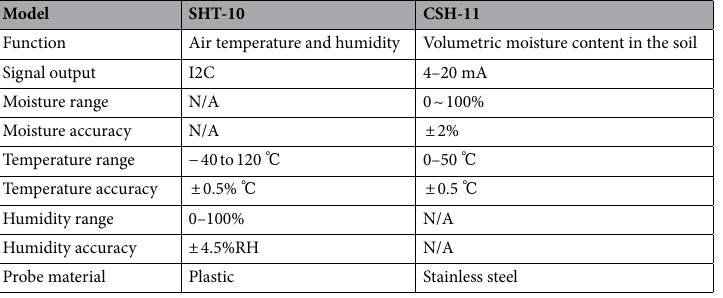
Table 4. Temperature and moisture sensors.